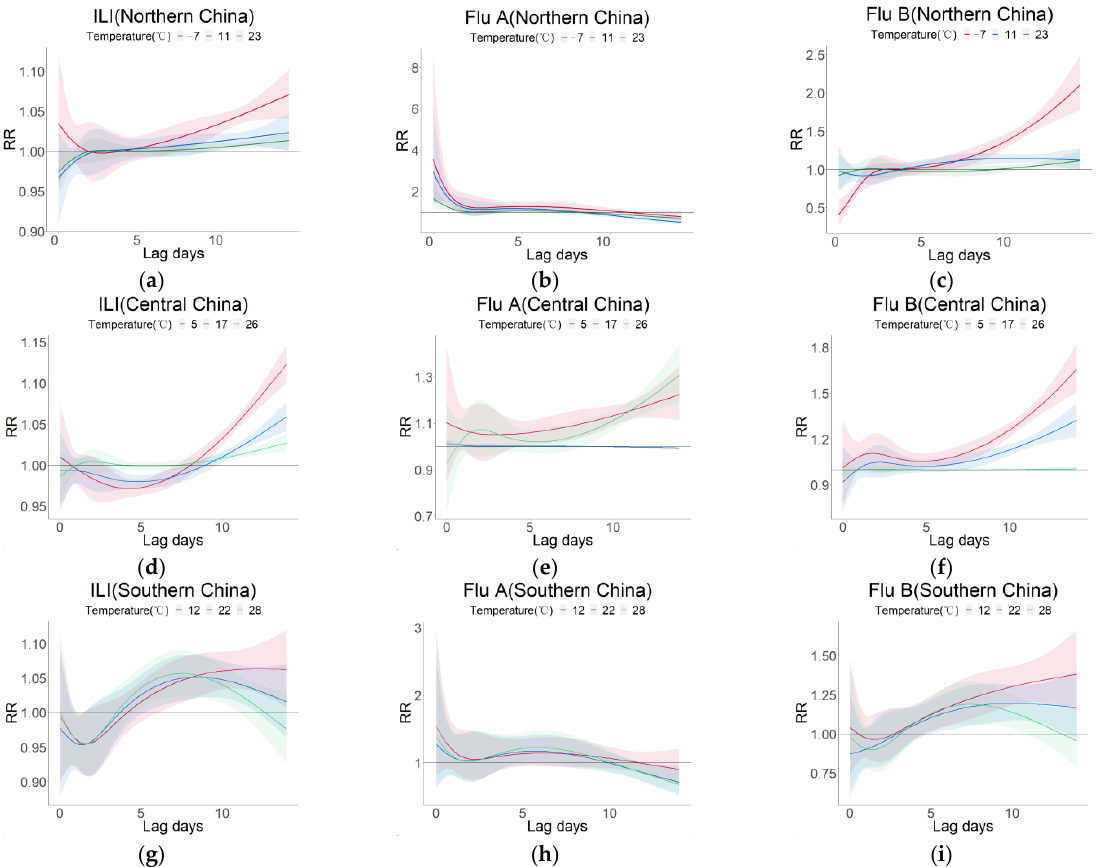
Figure 5. Relationship between the lag times of ILI, Flu A, and Flu B in different regions at specific temperatures (10%, 50%, 90%) with RR. The red line indicates the 10% quantile of the temperature in the area, the green line indicates the 50% quantile of the temperature in the area, and the blue line indicates the 90% quantile of the temperature in the area. ( a ) ILI in northern China; ( b ) Flu A in northern China; ( c ) Flu B in northern China; ( d ) ILI in central China; ( e ) Flu A in central China; ( f ) Flu B in central China; ( g ) ILI in southern China; ( h ) Flu A in southern China; ( i ) Flu B in southern China. The shaded area represents the 95% confidence interval. Abbreviations: ILI, influenza-like illness; Flu A, influenza A; Flu B, influenza B; RR, relative